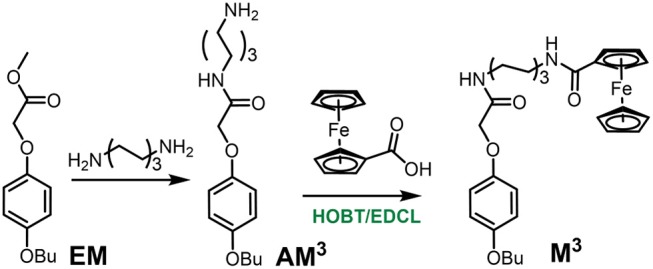
Synthetic route to monomer M3.